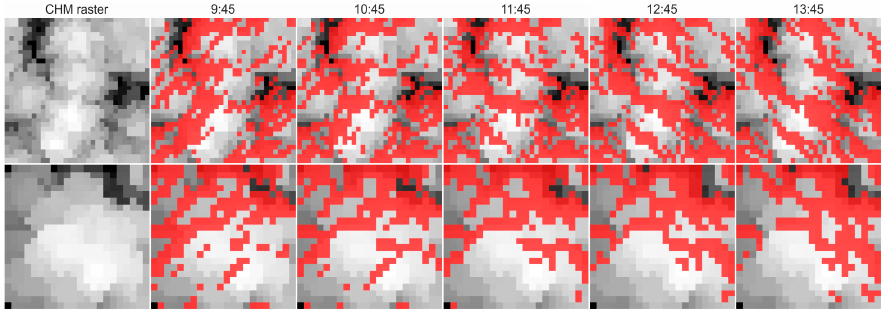
Figure 4. Canopy height model (CHM) raster images of trees measured using a spectrometer. On the left side, we show the structure of tree crowns as seen from above. Raster images are on a greyscale that indicates identified height of the pixel in the canopy. The upper row includes raw and α S images of spruce trees, lower row shows dynamics of beech tree. Dynamics of estimated shadow fraction in this area in 1 h steps near midday are shown with red color. Pictures show dynamics of shadows on 15 September.